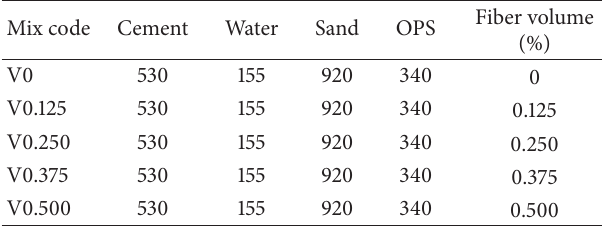
Table 4: Mix proportions (kg/m 3